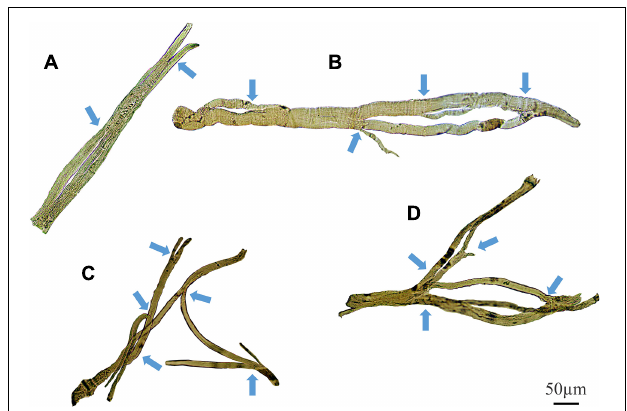
FIGURE 9 | Examples of medium power light microscope images (X100) of enzymatically digested EDL muscle fibers taken from a single 22-month-old dystrophic mouse. Note the fibers have been stitched together at the same magnification from photomicrographs taken from overlapping fields of view to capture a large portion of the fiber, scale bar provided at 50 µ m. Backgrounds debris from the digest process have been cleared to focus on the muscle fiber and arrows mark areas where fiber branching has occurred (To see examples where debris have not been removed see Kiriaev et al. (2018). (A) A fiber containing a single branch with slits forming within the trunk. (B) A fiber showing rejoining of these slits within the trunk and multiple offshoots off the edge of the muscle. (C,D) Examples of complex branched muscle